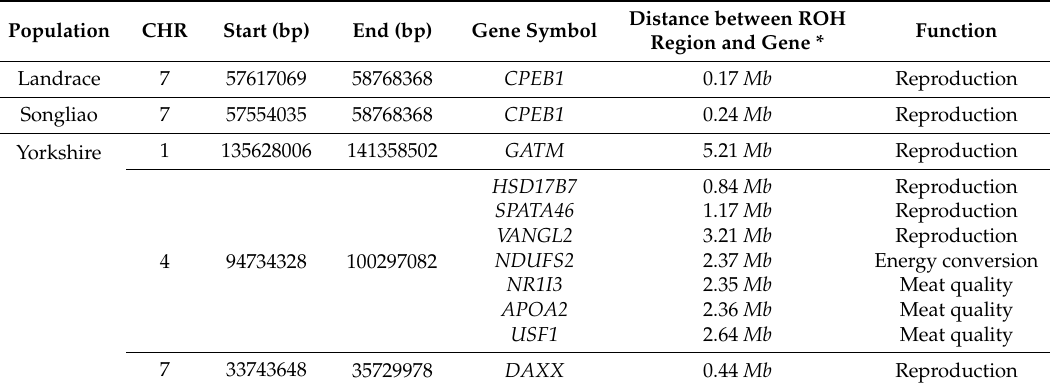
Table 4. Candidate genes located in genomic regions with a high frequency of ROH associated with pig economic traits.